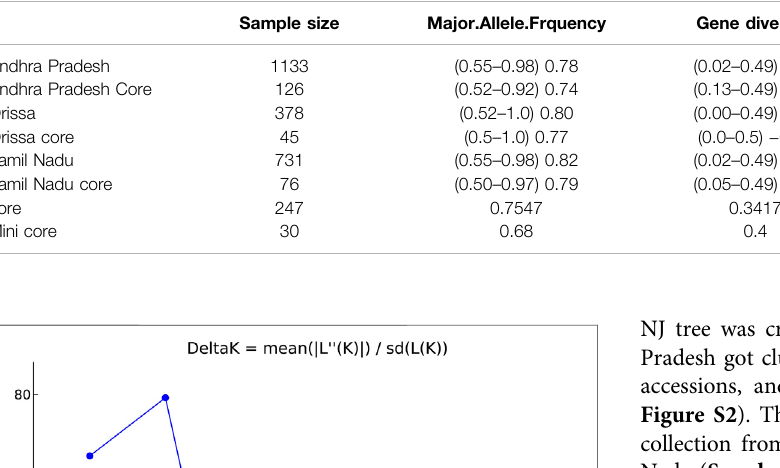
TABLE 2 | List of genetic diversity parameters estimated for three east coast states, core, and mini core set.